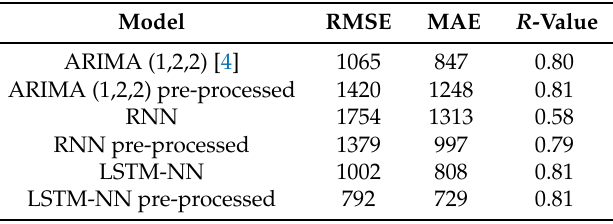
Table 5. Comparison of various forecasting